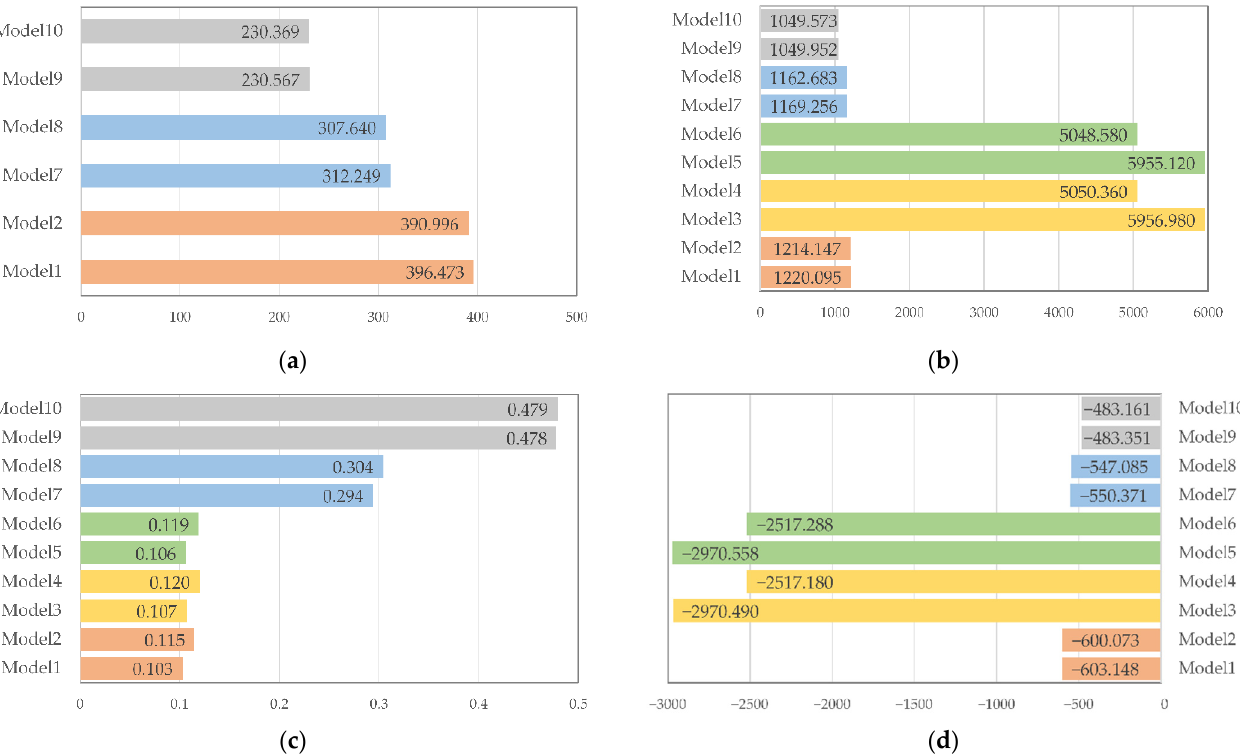
Figure 3. Comparison of the evaluation indexes of the 10 models. ( a ) Residual sum of squares (RSS); ( b ) Akaike information criterion (AIC); ( c ) R-squared (R 2 ); ( d ) Log-likelihood.